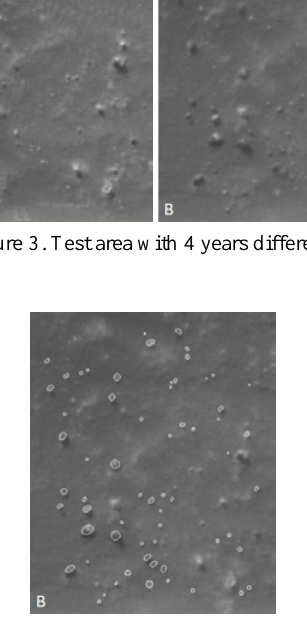
Figure 4. Desired change detection result Figure 4 represents the desired change detection result